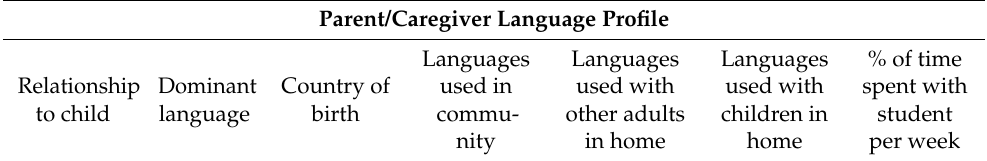
Table 2. Parent and Caregiver